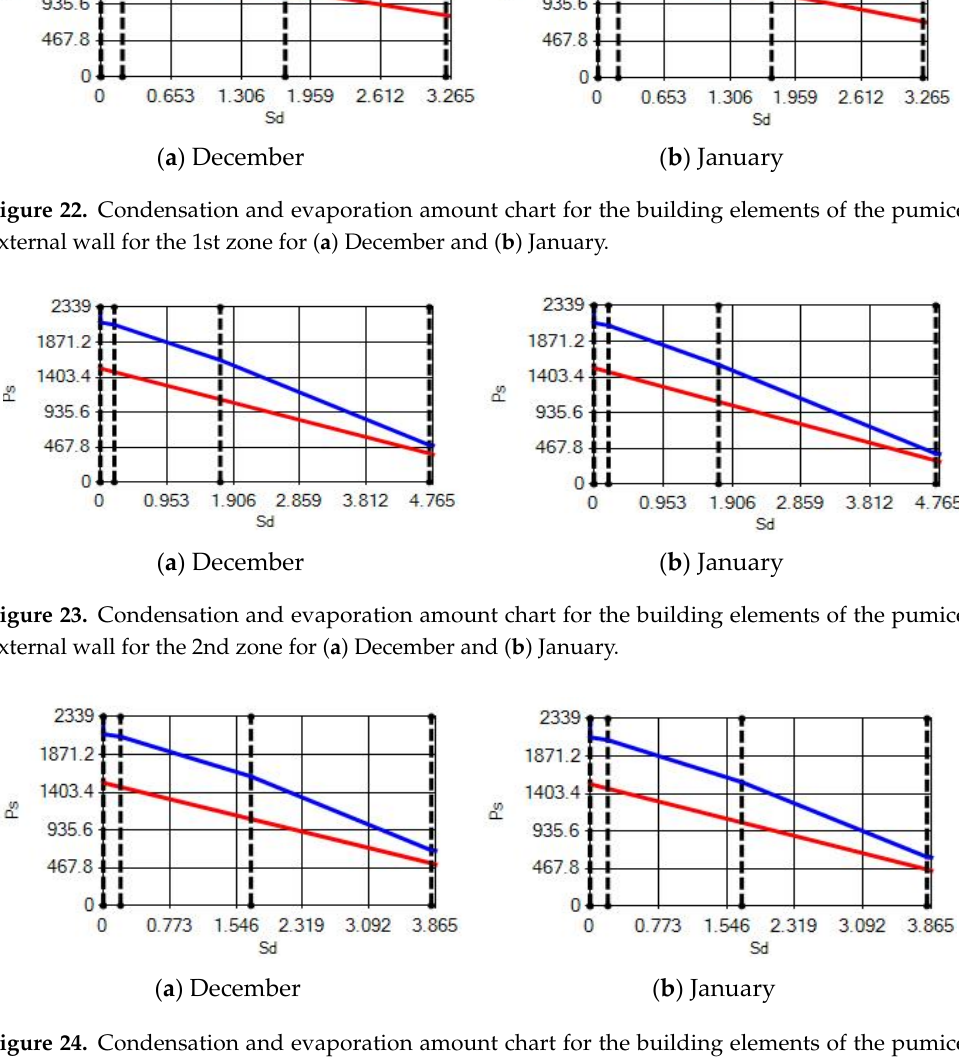
Figure 24. Condensation and evaporation amount chart for the building elements of the pumice external wall for the 3rd zone for ( a ) December and ( b ) January.